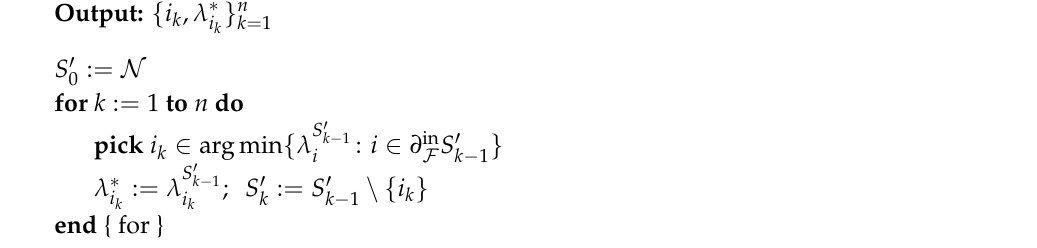
Algorithm 2: Adaptive-greedy algorithm: bottom-up version AG BU F